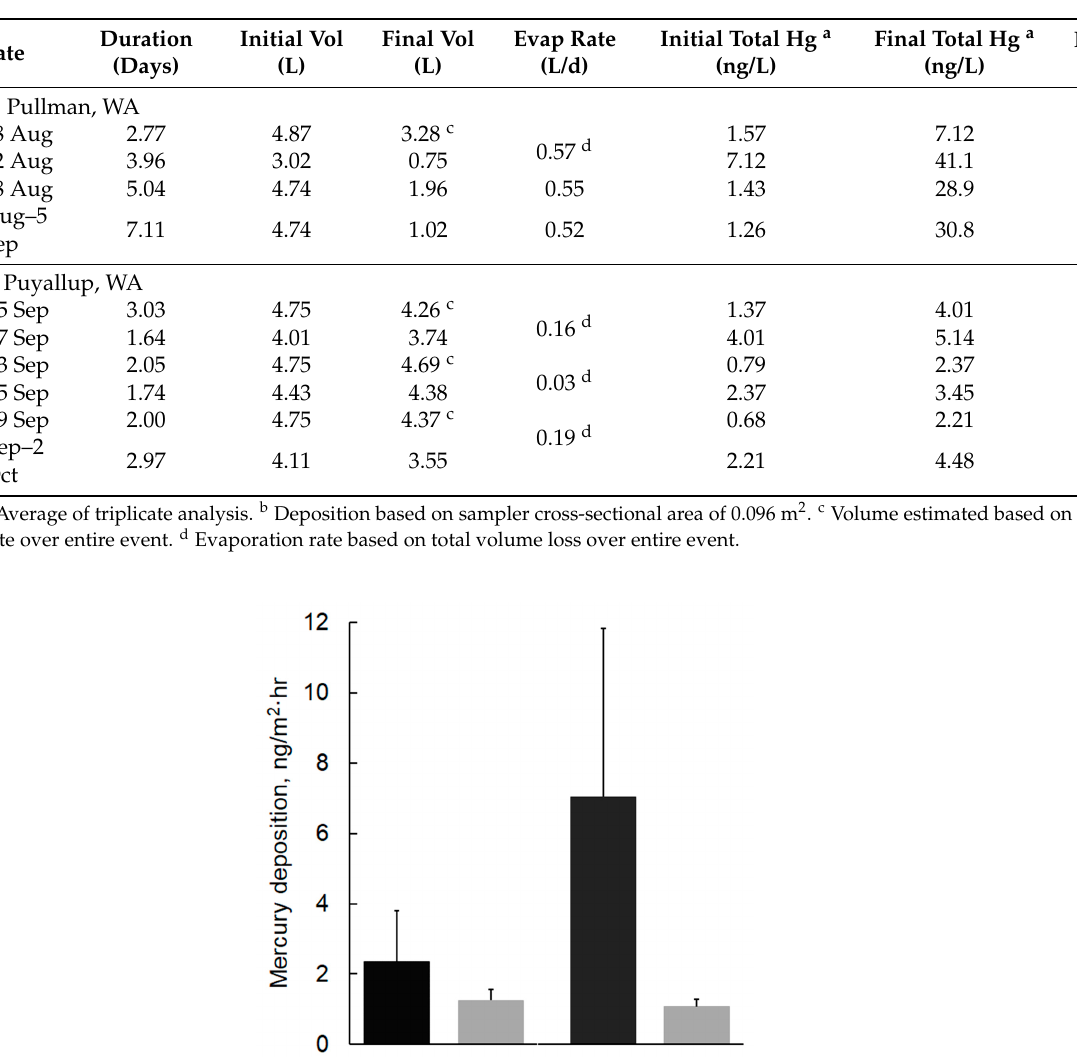
Table 1. Mercury dry deposition.